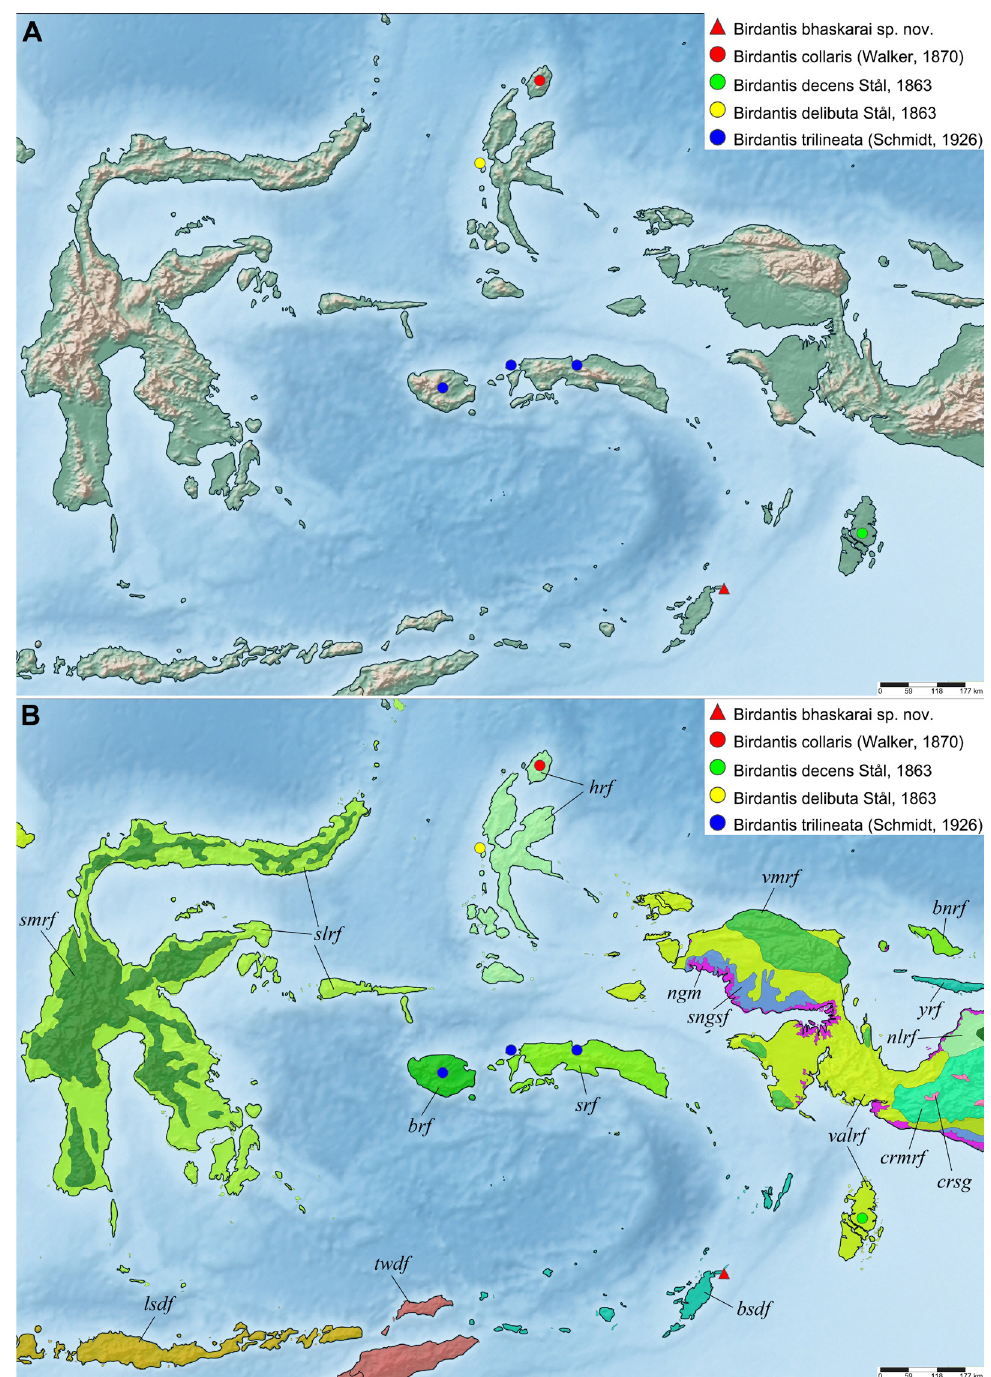
Fig. 3. Birdantis spp. from Maluku, distribution map. A . Topographic map. B . Ecoregions map. Abbreviations: bnrf = Biak-Numfoor rain forests; brf = Buru rain forests; bsdf = Banda Sea Islands moist deciduous forests; crmrf = Central Range montane rain forests; crsg = Central Range subalpine grasslands; hrf = Halmahera rain forests; lsdf = Lesser Sundas deciduous forests; ngm = New Guinea mangroves; nlrf = Northern New Guinea lowland rain forests; slrf = Sulawesi lowland rainforests; smrf = Sulawesi montane rainforests; sngsf = Southern New Guinea freshwater swamp forests; srf = Seram rain forests; twdf = Timor and Wetar deciduous forests; valrf = Vogelkop-Aru lowland rain forests; vmrf = Vogelkop montane rain forests; yrf = Yapen rain